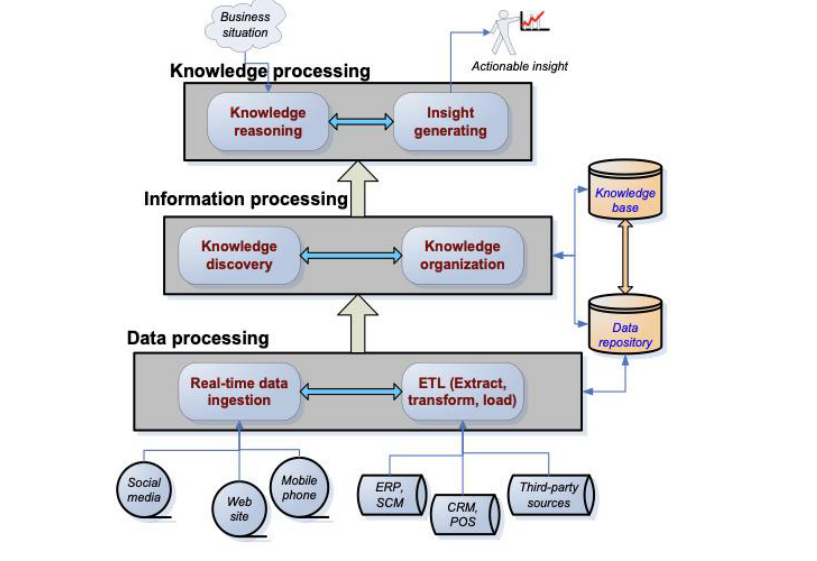
Fig. 1. Smart data transformation